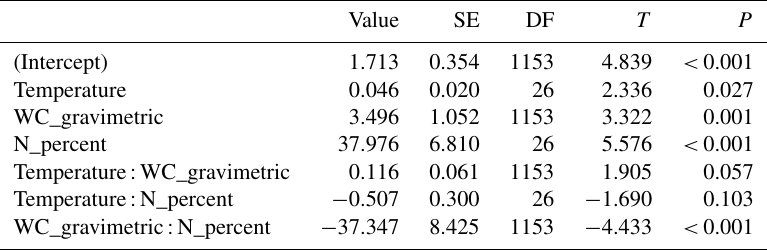
Table A1. Linear mixed-effect model parameters, testing effects of temperature ( ◦ C), gravimetric water content (unitless), soilN (%),and dissolved organic carbon (DOC, mgkg − 1 ) on log-transformed, individual core CH 4 fluxes ( + 0.1µgCgC − 1 day − 1 ) ; a colon (“:”) indicates an interaction. Dependent variable has units of log(µgCgC − 1 day − 1 ) . Columns include parameter value, standard error (SE), degrees of freedom (DF), T statistic, and P